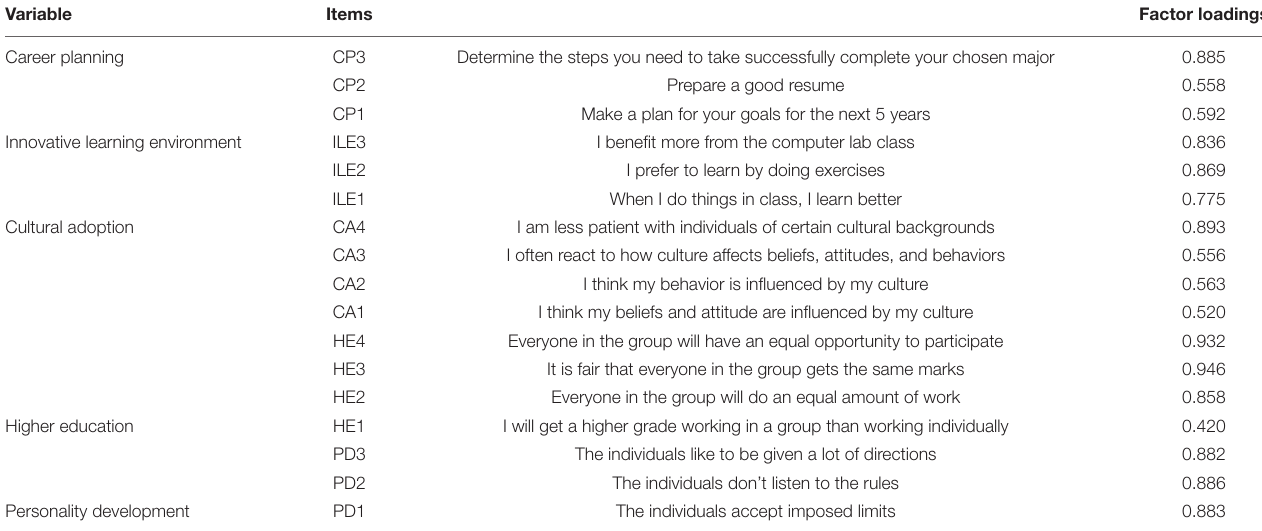
TABLE 1 | Results of confirmatory factor analysis. Variable